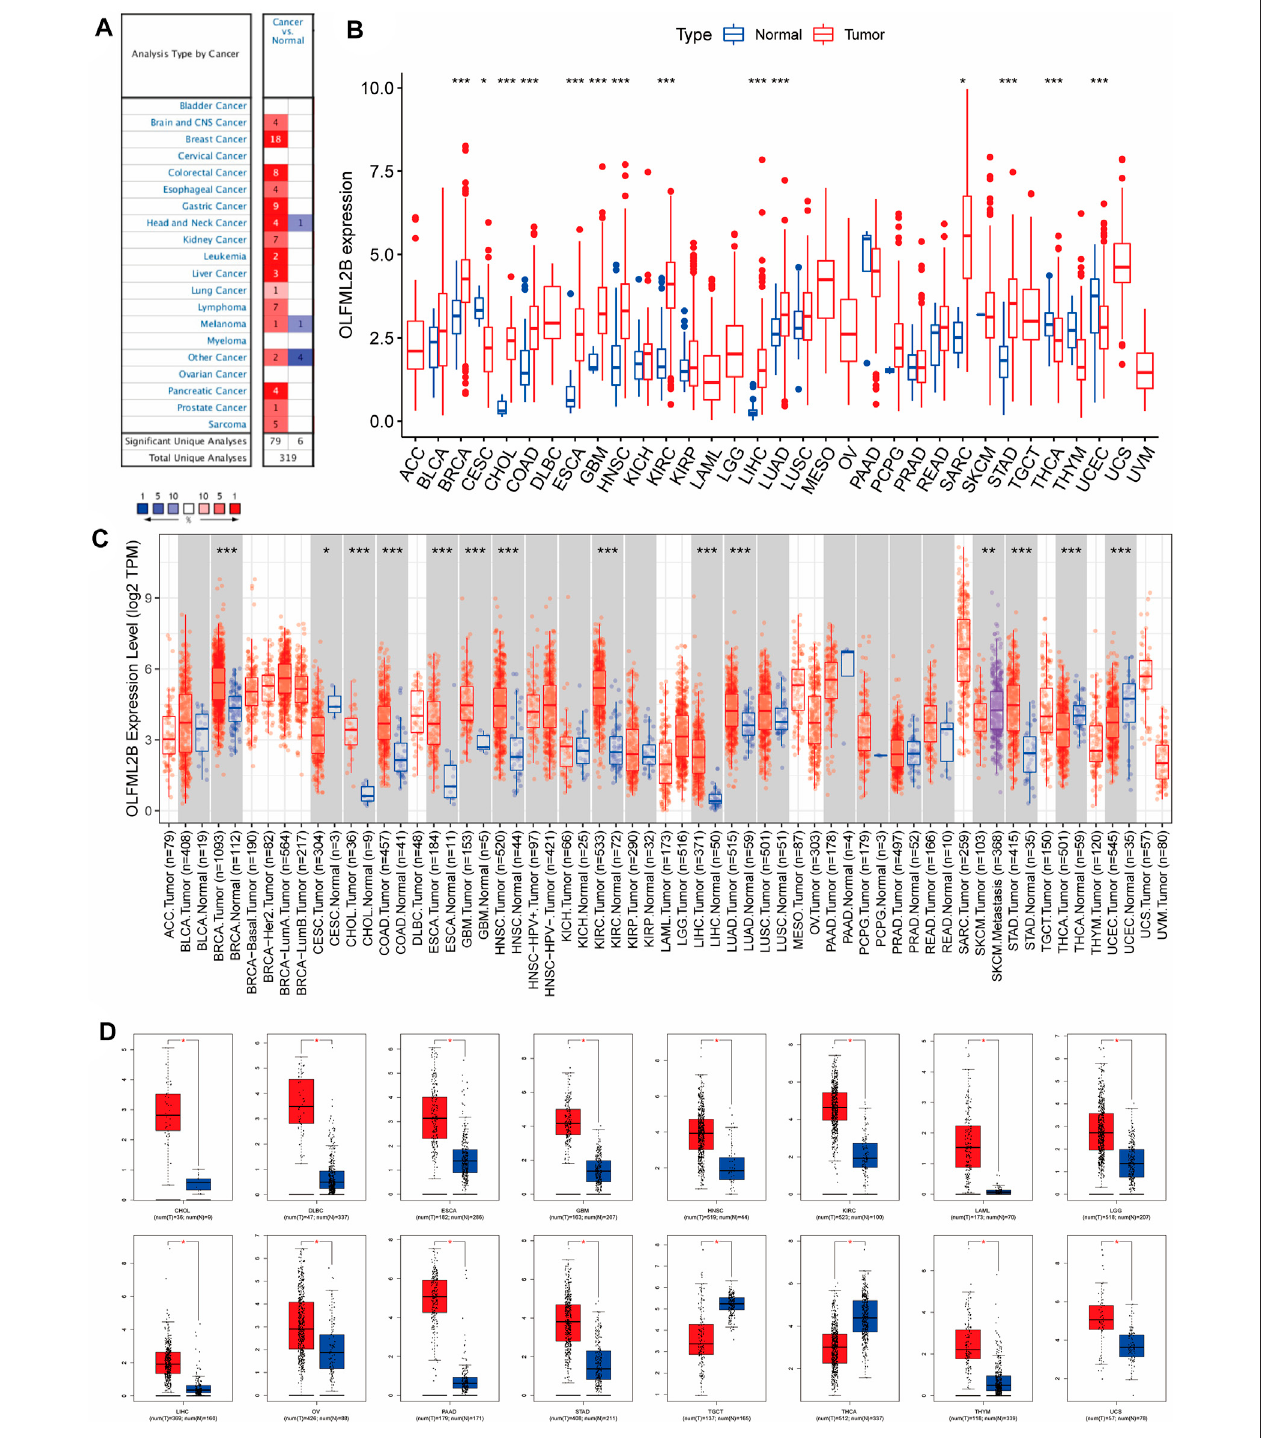
FIGURE 1 | Pan-cancer OLFML2B expression level. (A) Expression level of OLFML2B in the Oncomine database. (B) Expression level of OLFML2B in the TCGA database. (C) Expression level of OLFML2B in the TIMER2.0 database. (D) Expression level of OLFML2B in the GEPIA database.